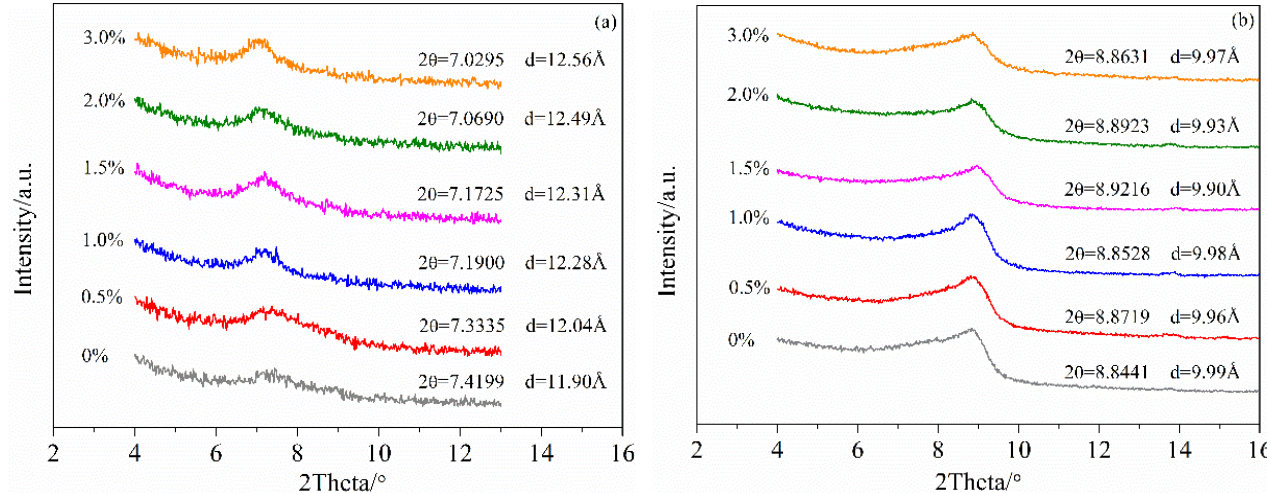
Figure 9. X-ray diffraction pattern of dry bentonite samples treated by a filtrate reducer: ( a ) LDMS; ( b ) Driscal.